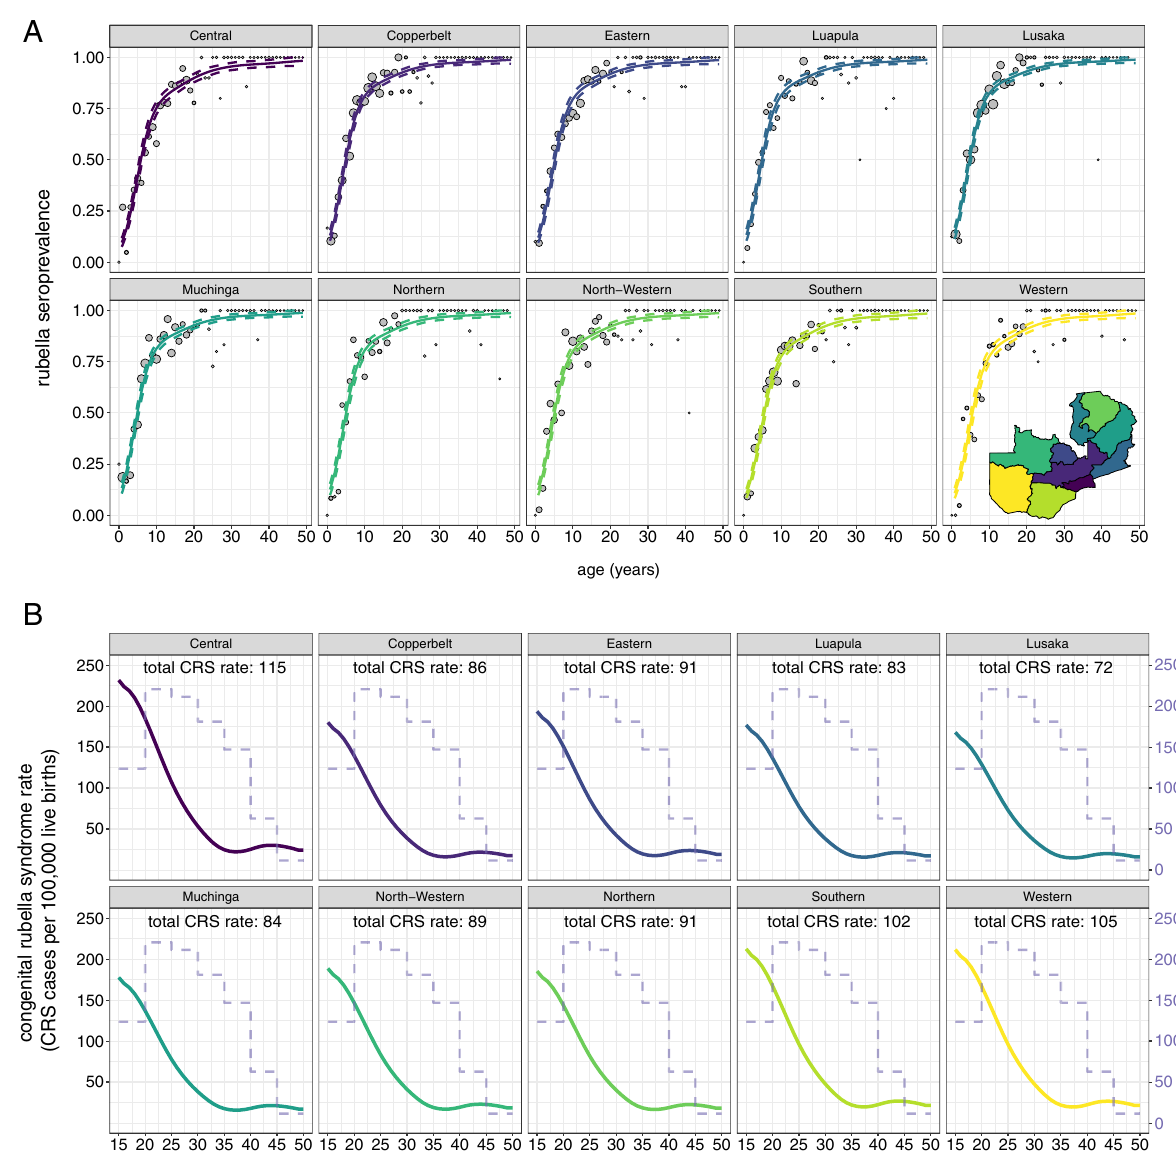
Figure 5. Age-specific rubella seroprevalence and CRS rate by province. ( A ) Rubella age-specific seroprevalence by province. The points represent the data grouped by age in years with the exception of year 0 which includes only individuals 10 and 11 months old and are proportional to the number of individuals in each age in years. The lines represent fitted generalized additive model mean (solid line) and 95% confidence intervals (dashed lines). ( B ) Provincial age-specific CRS rate (solid line), and national age-specific fertility rate (dashed line). The total provincial CRS rates (labeled in text at the top of each plot) is the weighted average of the age- specific CRS rate by age-specific fertility